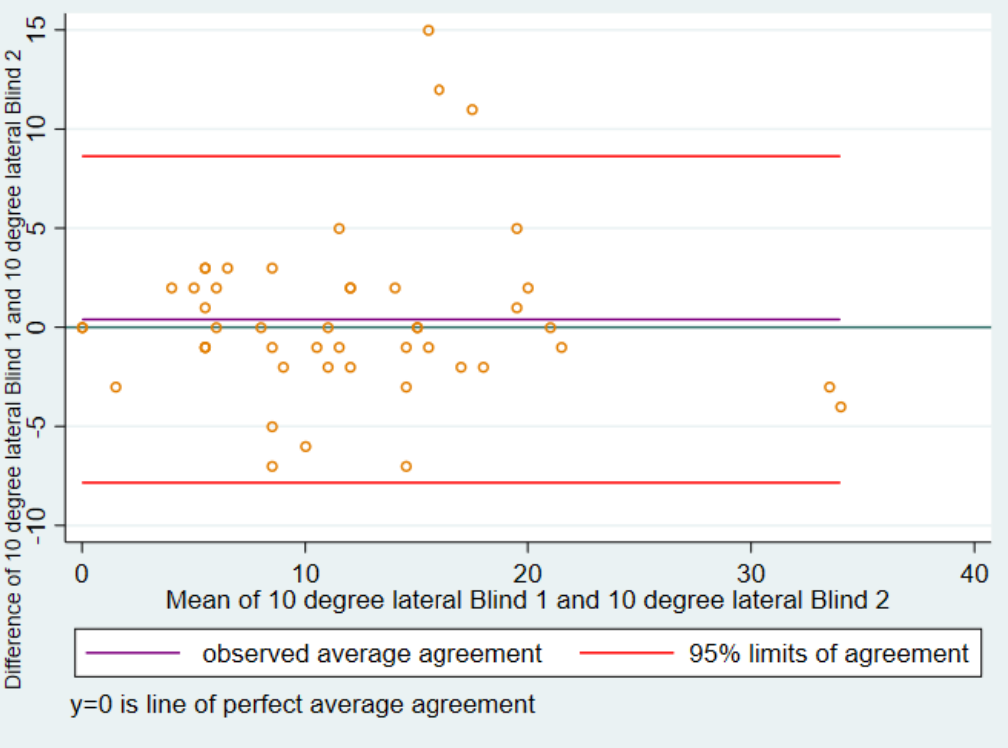
Figure 1. Ten degrees, lateral.